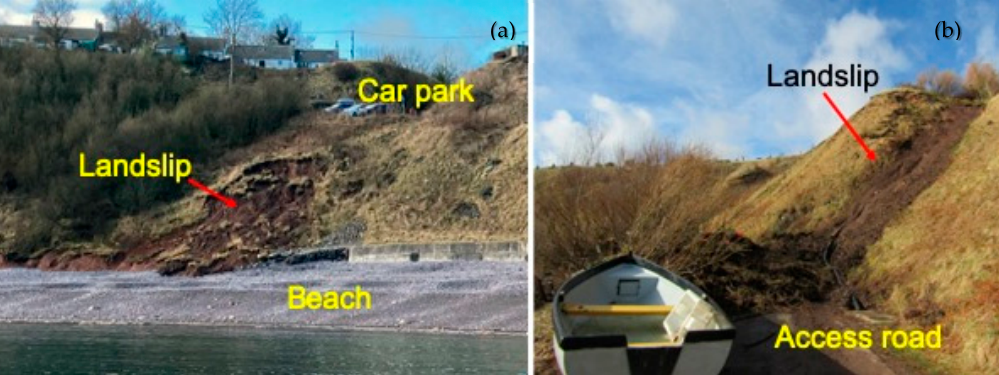
Figure 8. Landslips that occurred in ( a ) February 2021 and ( b ) 2020 in areas previously mapped as ‘high risk’ by the proposed GIS-based tool (Figure 4).